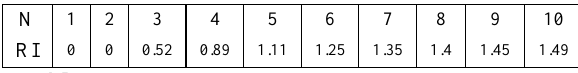
Table 5 . Random Index values according to saaty and Tran.